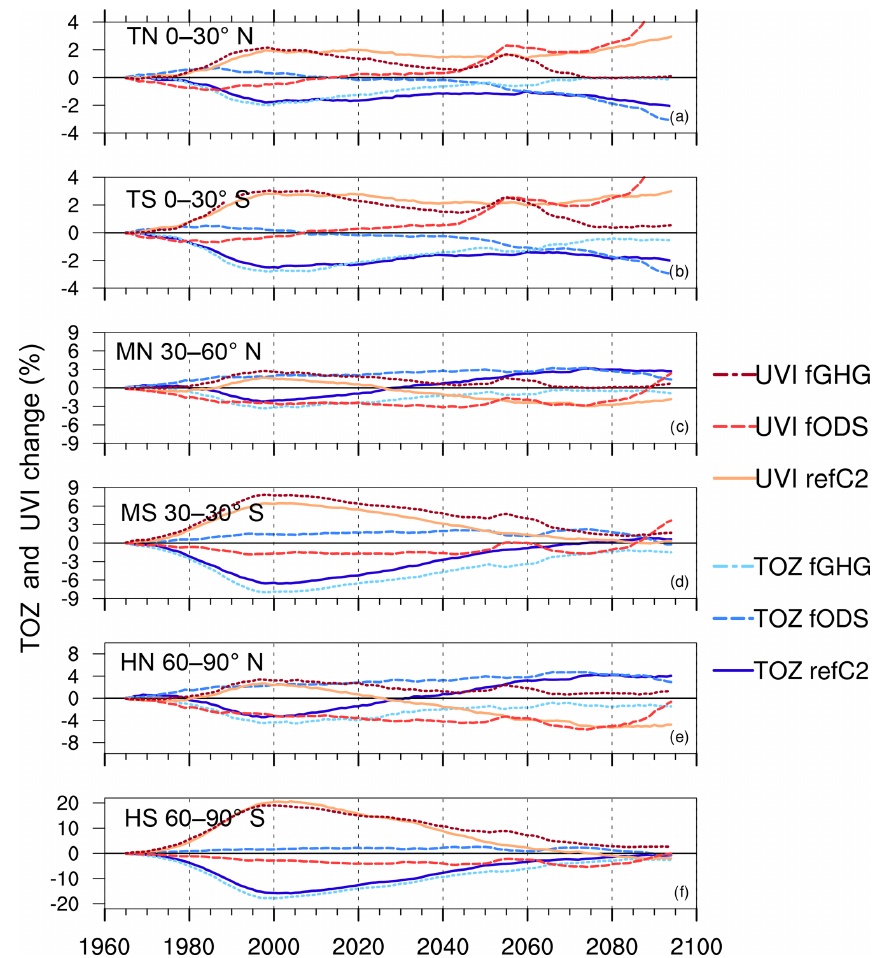
Figure 6. UVI and TOZ percent changes (relative to 1960s values) for six latitudinal bands: northern tropical band (HN, 0–30 ◦ N), southern tropical band (HS, 0–30 ◦ S), northern mid-latitude band (MN, 30–60 ◦ N), southern mid-latitude band (MS, 30–60 ◦ S), northern high-latitude band (HN, 60–90 ◦ N), southern high-latitude band (HS, 60–90 ◦ S). UVI changes are represented in different shades of blue for the three EXP2 scenarios. TOZ changes are represented in different shades of